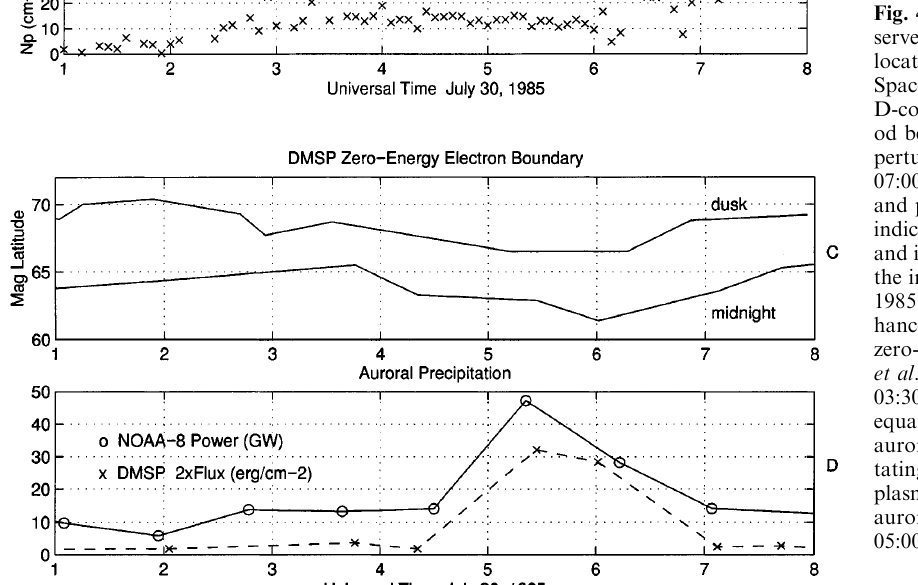
Fig. 4. A Magnetic field variations ob- served by the Bell Labs magnetometer located on the field line intersecting the Spacelab-2 OMS burn. A pronounced D-component oscillation with 80-min peri- od began at 03:31 UT. A negative